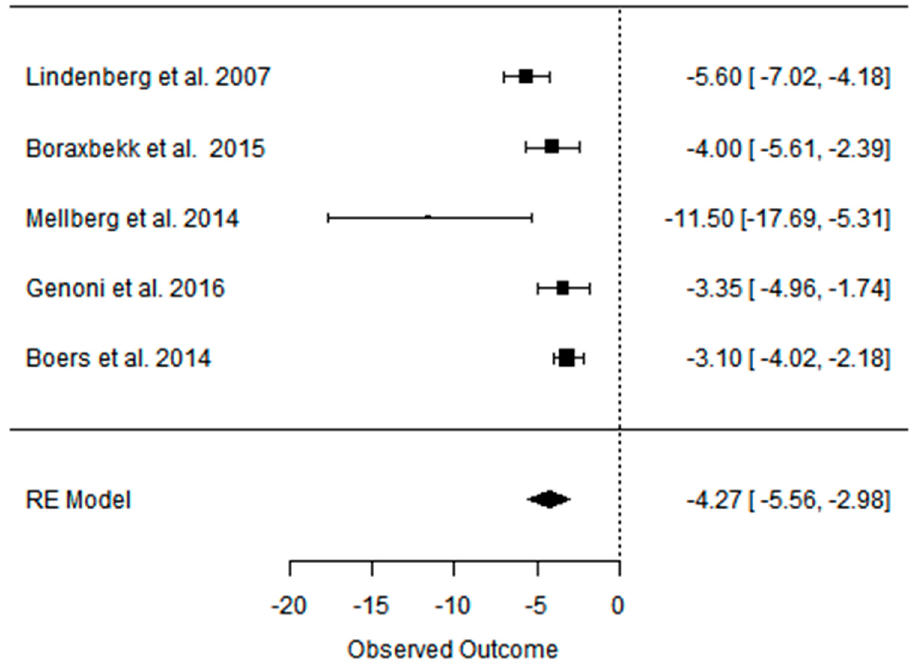
Figure A8. Forest plot of the effect of PD on waist circumference (cm) in the short term (weighted mean difference).